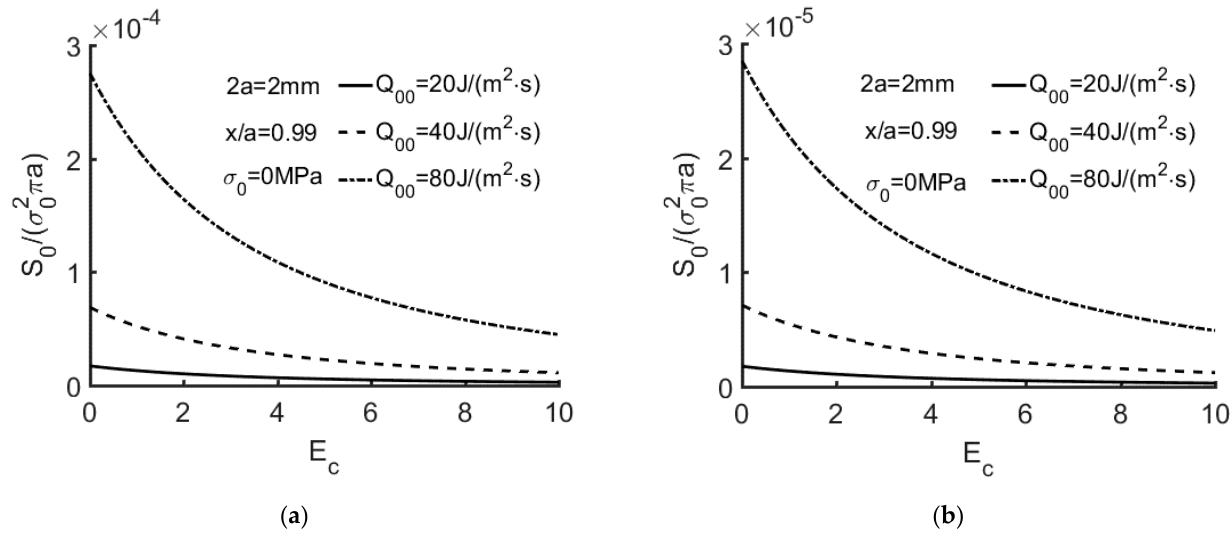
ε ε = 0.01. (2 a = 2mm, x/a = 0.99, σ 0 = 0 MPa). The ortho- = 0.01. (2 a = 2mm, x/a = 0.99, σ 0 = 0 MPa). The ortho- ε ε = 0.01. (2a =2 mm, x/a = 0.99, = 0.01. (2a =2 mm, x/a = 0.99,